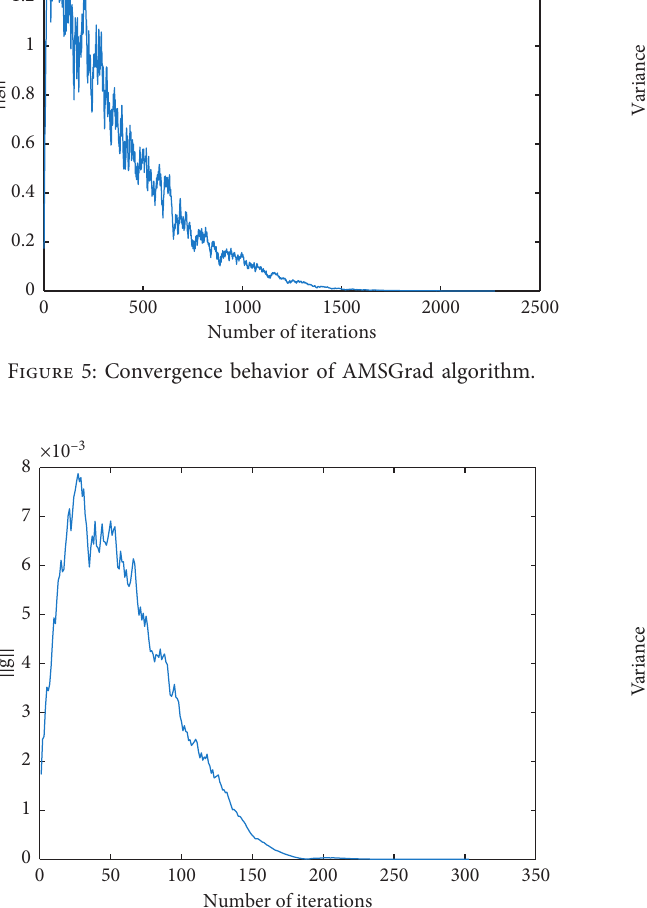
Figure 6: Convergence behavior of AdamSE algorithm.